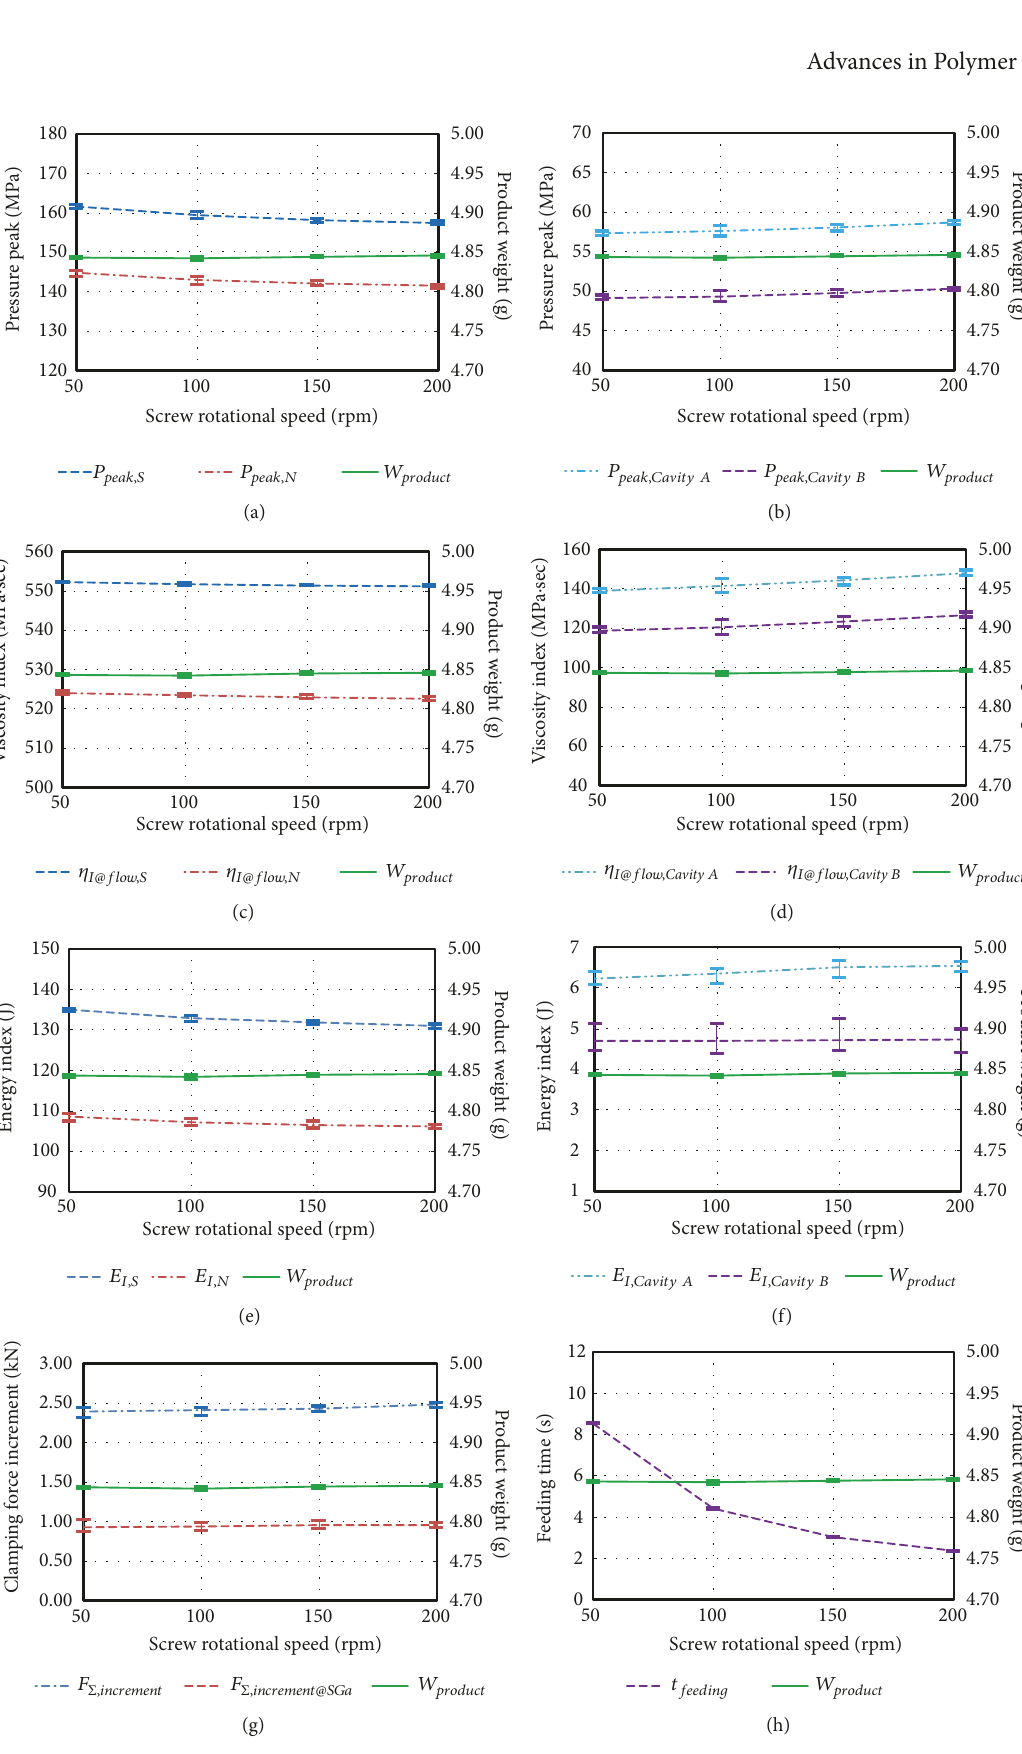
Figure 11: Variation of quality indexes and product weight with screw rotational